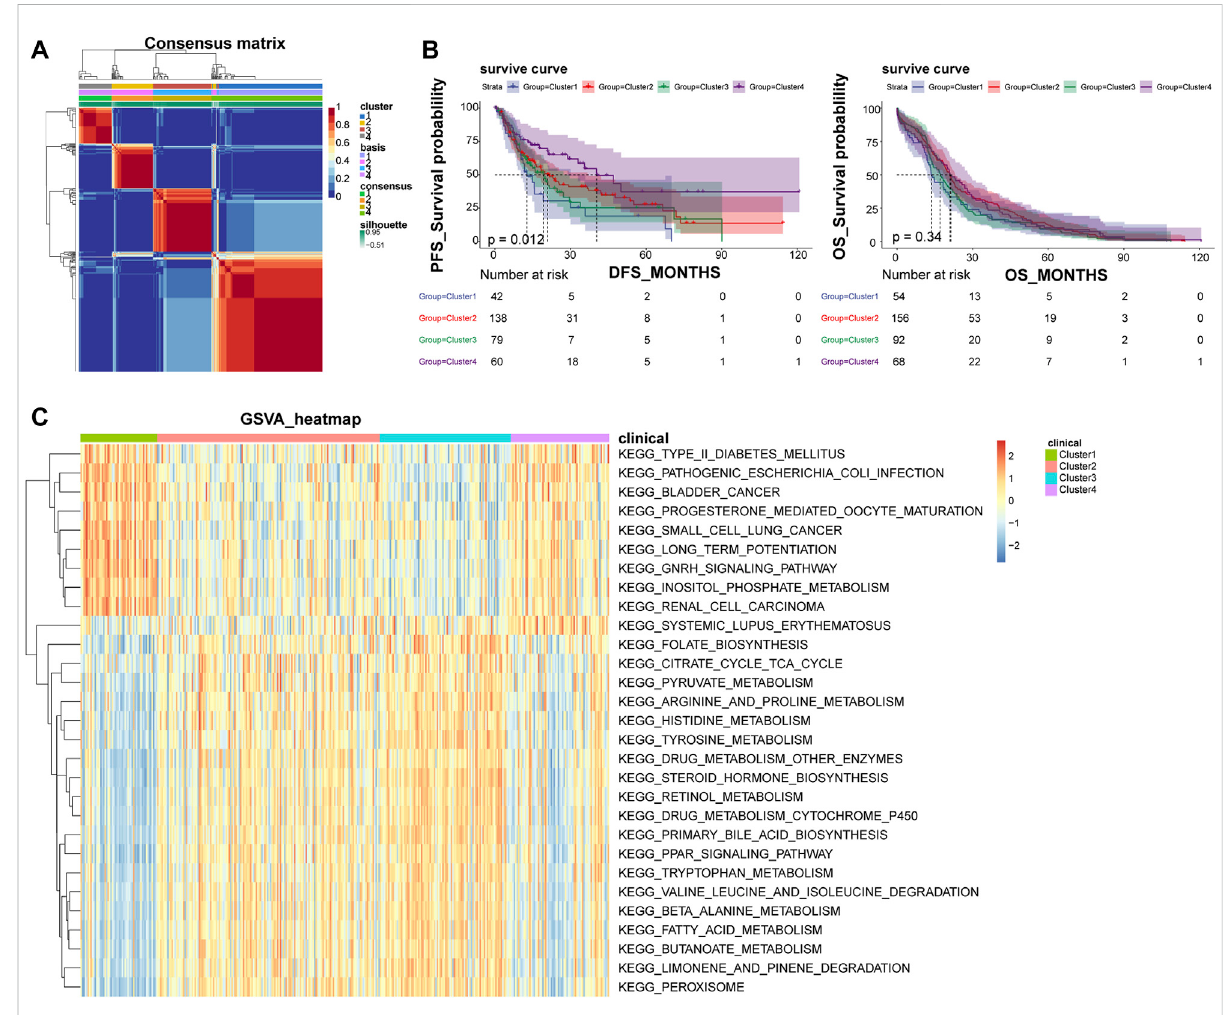
FIGURE 1 NMF clustering classify LIHC patients into four different subtypes. (A) Heat map of NMF clustering. (B) Survival curves of patients with different diseasesubtypes.TheleftpanelshowstheOSsurvivalcurve,andtherightpanelshowstheDFSsurvivalcurve. (C) HeatmapoffoursubtypesofGSVA enrichment pathways; NMF, negative matrix factorization; OS, overall survival; DFS, disease-free